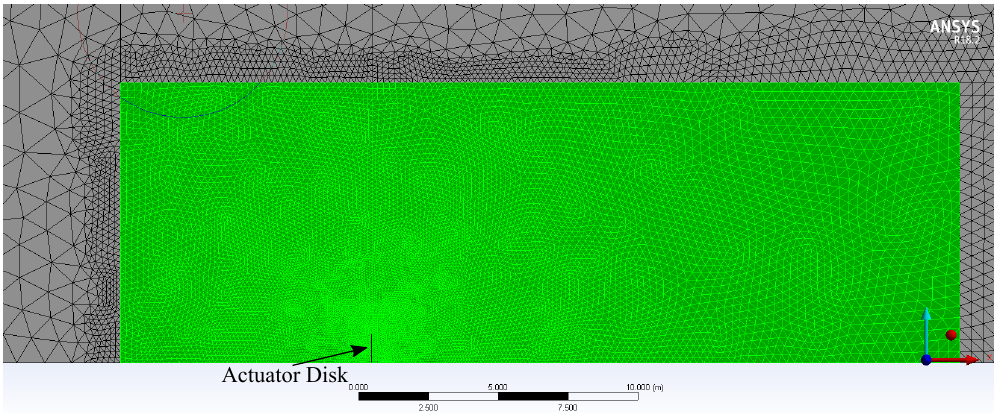
Figure 6. Close-up view of the actuator-disk region in one of the meshes used in this study. The region highlighted in green in depicts the local domain extending 21 m downstream and 9 m upstream of the actuator